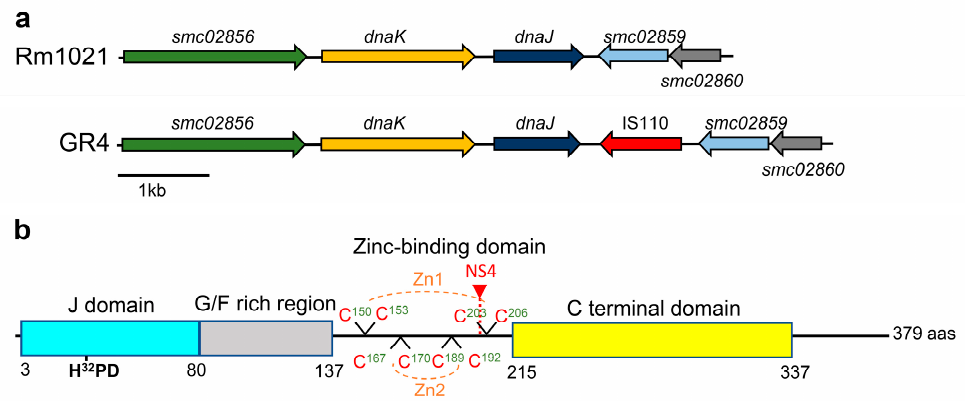
Figure 1. In silico analyses of S. meliloti dnaJ . ( a ) Genomic context of dnaJ in S. meliloti strains Rm1021 and GR4. The arrows represent open reading frames. The transposase encoded by the insertion sequence IS110 in GR4 is shown in red. smc02856 encodes a putative penicillin-binding protein; dnaK and dnaJ code for the Hsp70 and Hsp40 chaperones, respectively; smc02859 - smc02860 encodes hypothetical proteins of unknown function. ( b ) Domain architecture of the S. meliloti DnaJ protein. The conserved HPD motif in the J-domain is shown in bold. The eight cysteines putatively conforming two zinc-binding domains are indicated in red. The location of the Tn 5 insertion in the NS4 transposant is shown with a red triangle.